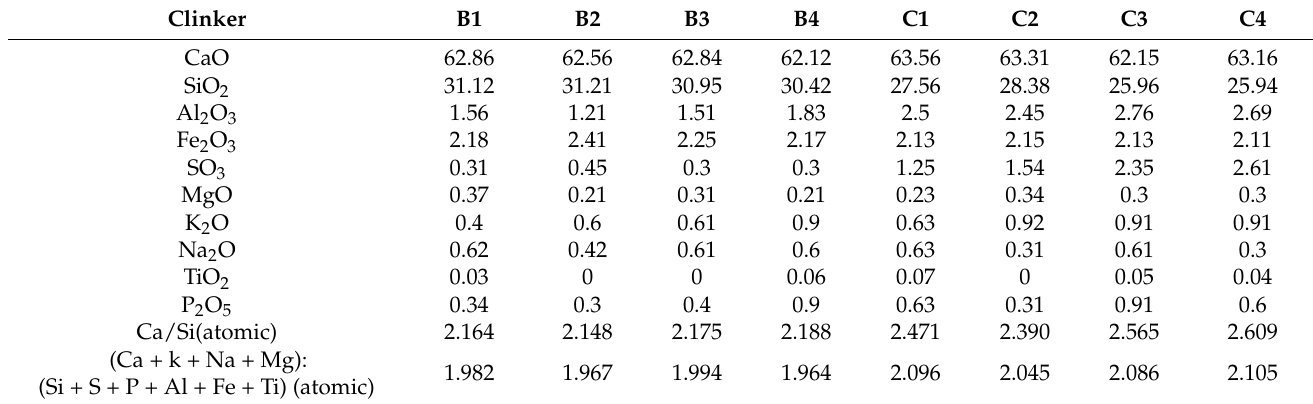
Figure 9. Microstructure of belite-rich clinker ( a ) B4 ( b ) C4. Table 9. Average chemical composition of belite grains in clinkers (wt. %).